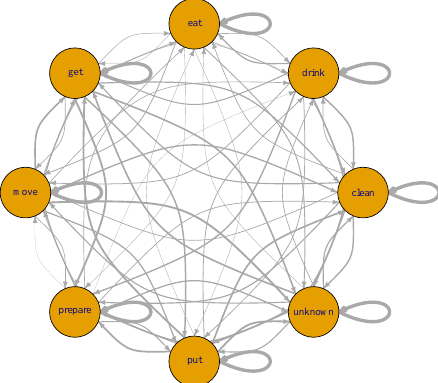
Figure 9. The HMM used for activity recognition. Each state represents an action class. Thicker lines indicate higher transition